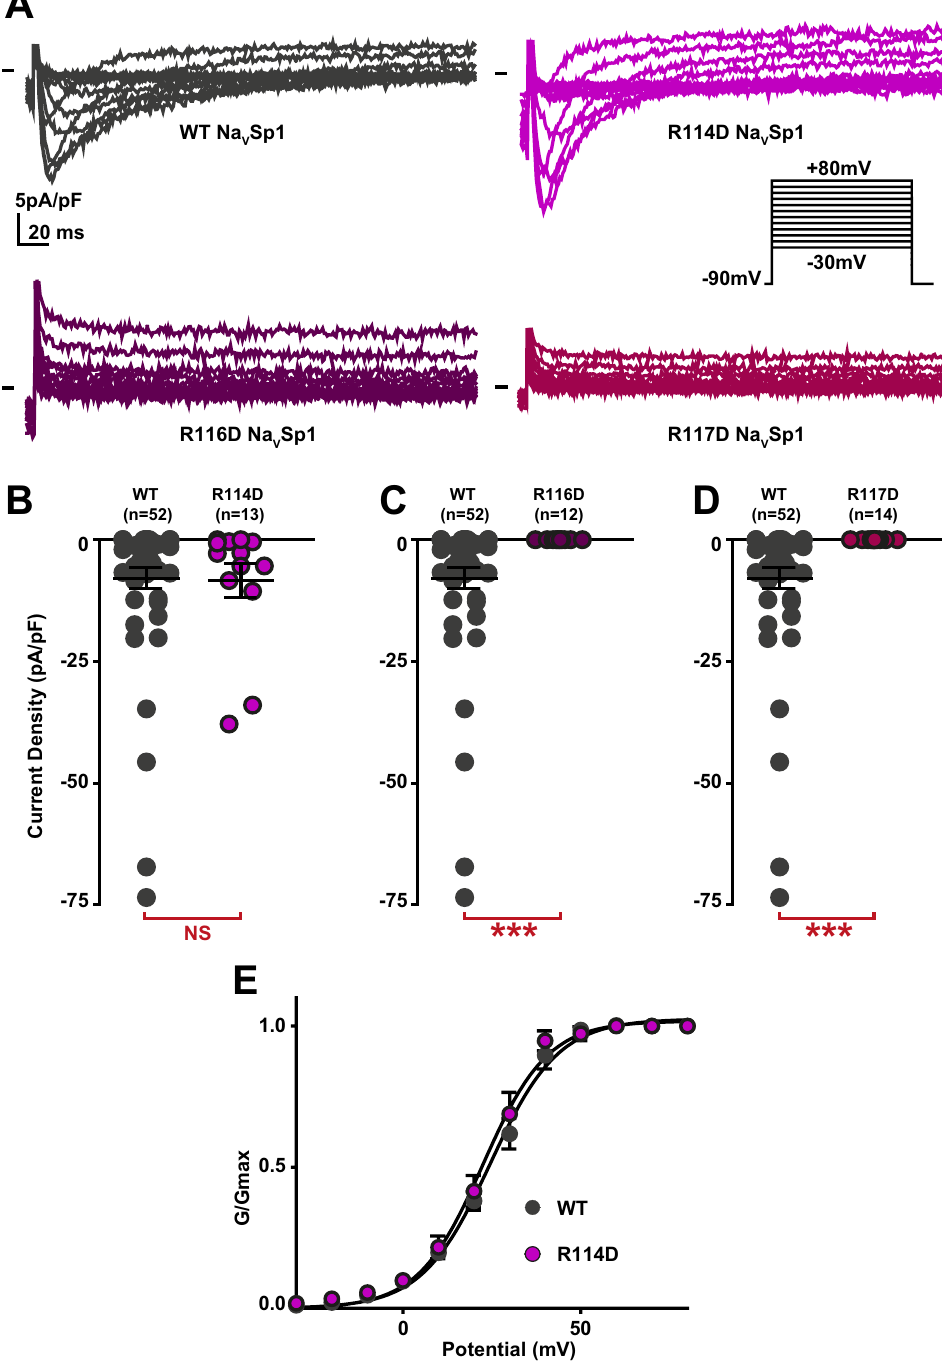
Figure 3. Effect of charge reversal in amino acids present in Na V Sp1 S4-S5 L ( − 3) activating peptide on Na V Sp1 current density and activation curve. ( A ) representative, superimposed recordings of WT and mutant Na V Sp1 current. Activation voltage protocol used is the same as in Fig. 2. ( B–D) Dot plot and mean ± sem of peak current densities recorded in COS-7 cells transfected with WT or mutant Na V Sp1, at 30 mV. ( E) Relative peak conductance versus membrane potential curves for WT or mutant Na V Sp1 channels transfected in COS-7. Lines are Boltzmann fits to the data. *** p value vs . WT <